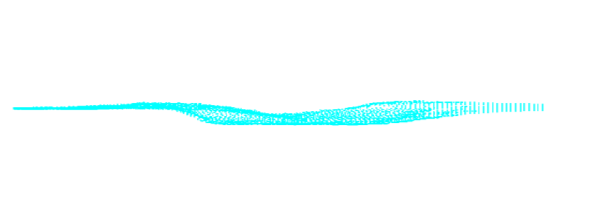
Figure 4: Side view of point cloud that generated by Kriging